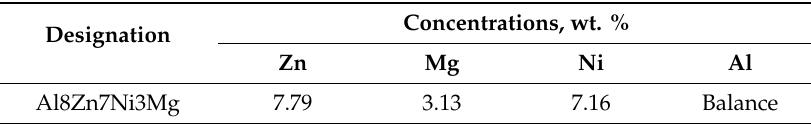
Table 1. Chemical composition of the experimental